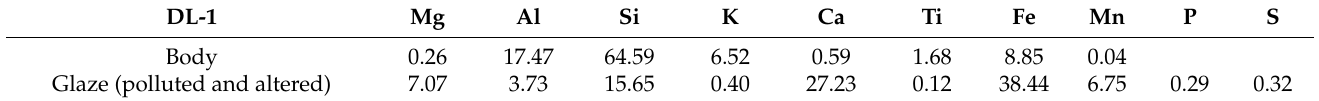
Table 1. EDXRF analysis results of the major and minor elements of the body and glaze (wt%).